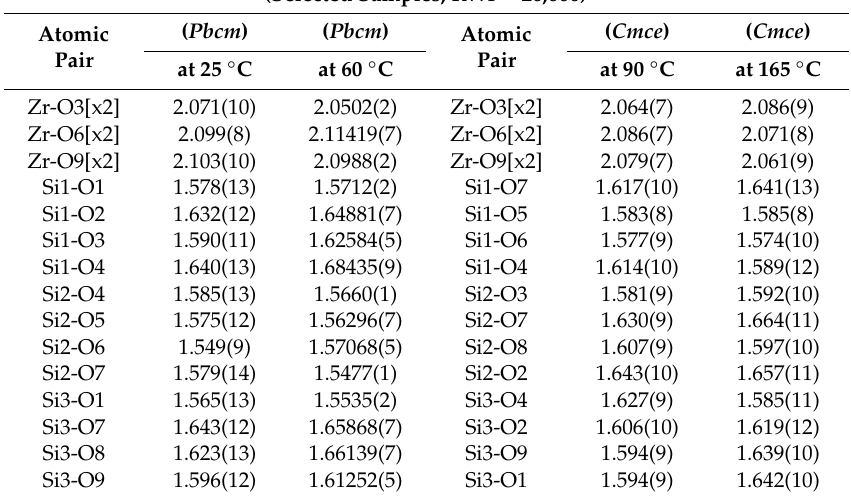
Table 4. Selected bond distances (Å) for heated elpidite samples obtained within the temperature range 25–165 °C.